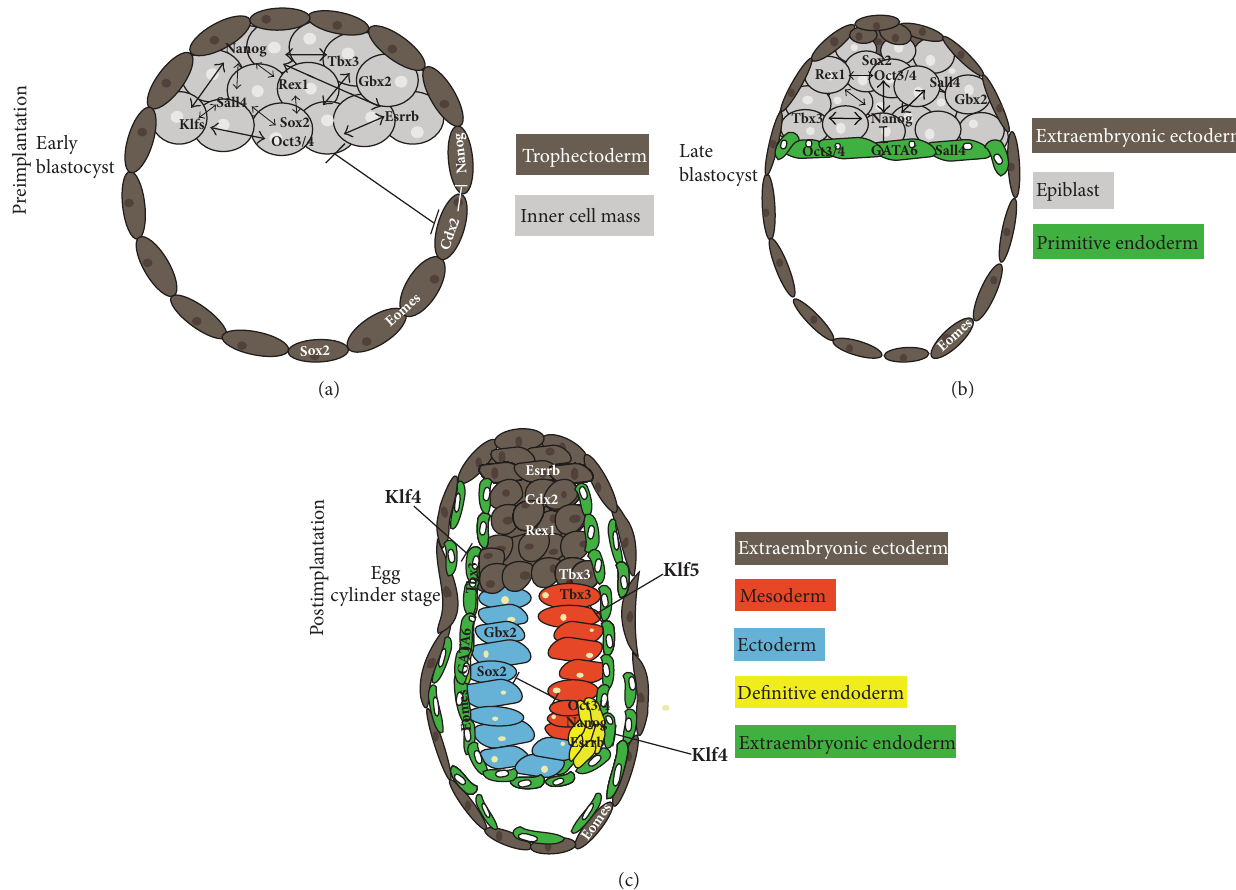
Figure 2: Pluripotency factor expression during early embryonic development. Pluripotency factors are expressed throughout the pluripotency state and subsequently govern early lineage decisions in mouse. (a) The early blastocyst consists of the ICM and the outer trophectoderm. Pluripotency factors are expressed in the ICM, however, interacting with trophectodermal genes for proper lineage development.(b)Atthelateblastocyststage,theICMsegregatesintotheepiblast,notablyexhibitingslightlydifferentgeneexpressionpatterns, and into the extraembryonic endoderm, later giving rise to yolk sac. Further, the trophectoderm has formed the extraembryonic ectoderm lineage which will generate the placenta. (c) After implantation, the primitive ectoderm, which has origins in the epiblast, forms the four embryo-derived stem cell lineages (ectoderm, mesoderm, endoderm, and germ lineage). Notably, pluripotency factors guide early embryonic decision according to their expression profile, respectively. ICM: inner cell